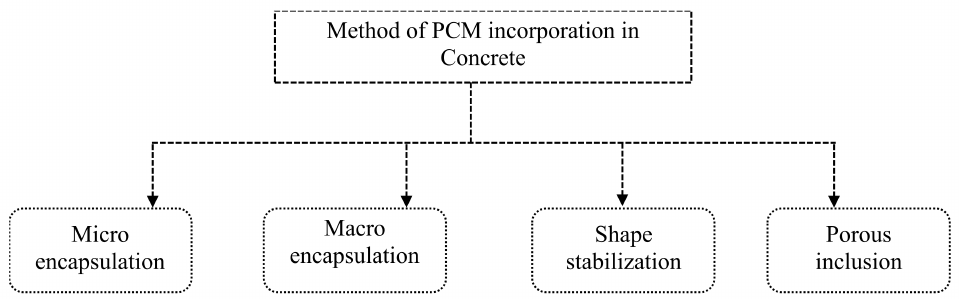
Figure 8. Four different methods of incorporating PCM in